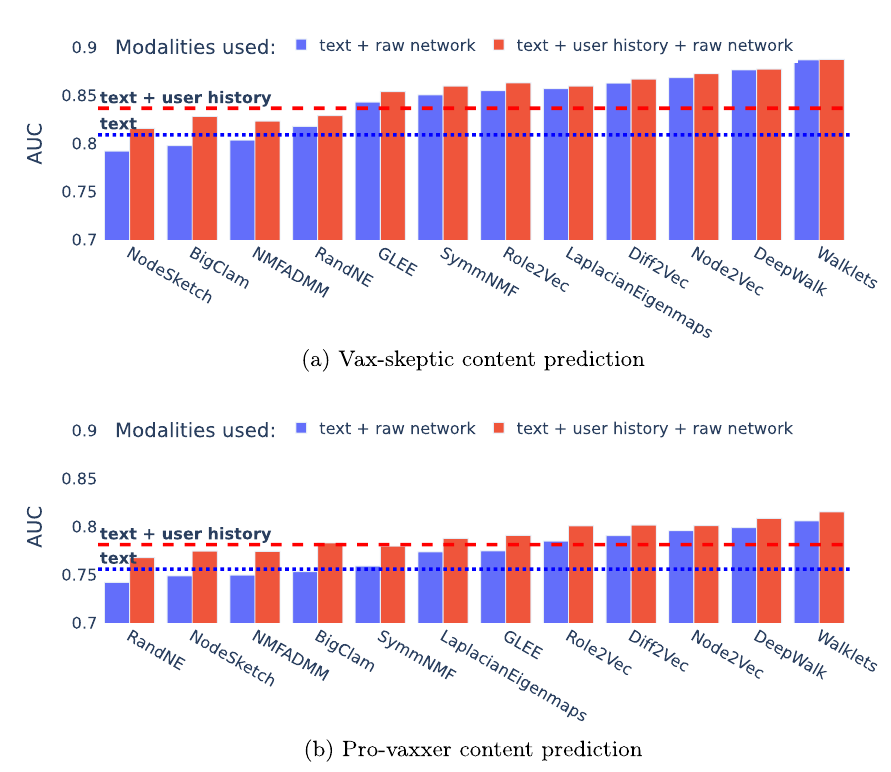
Fig. 11 Performance (AUC) using different node embedding and community detection